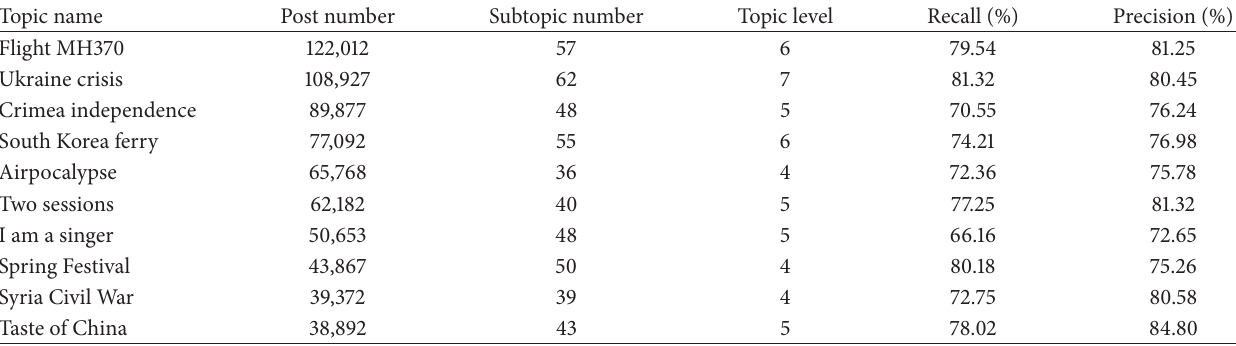
Table 2: Hot topic ranks with related metrics.